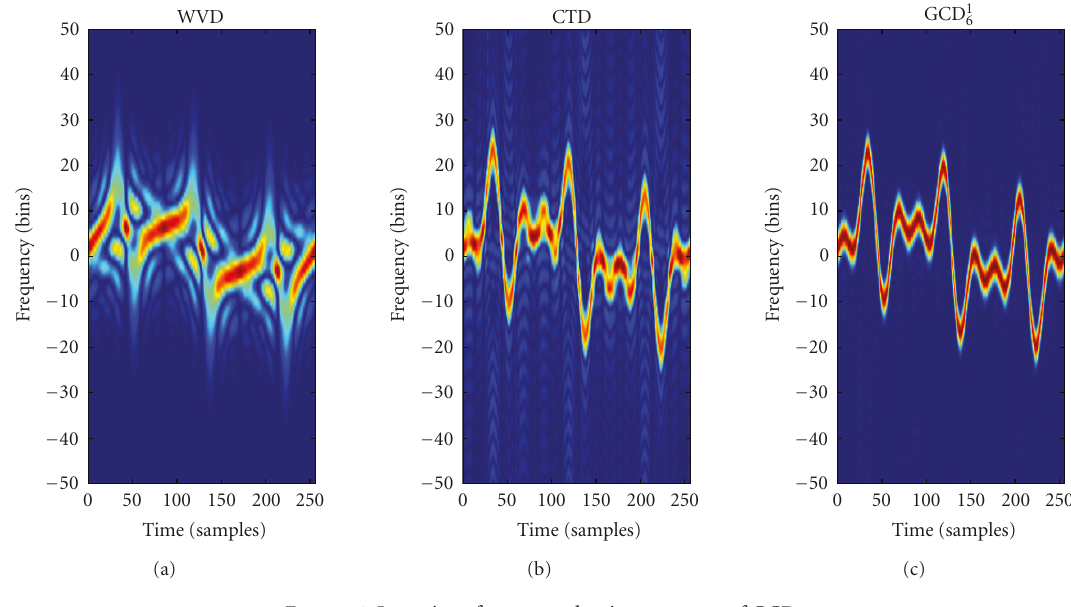
Figure 4: Inner interferences reduction property of GCD.